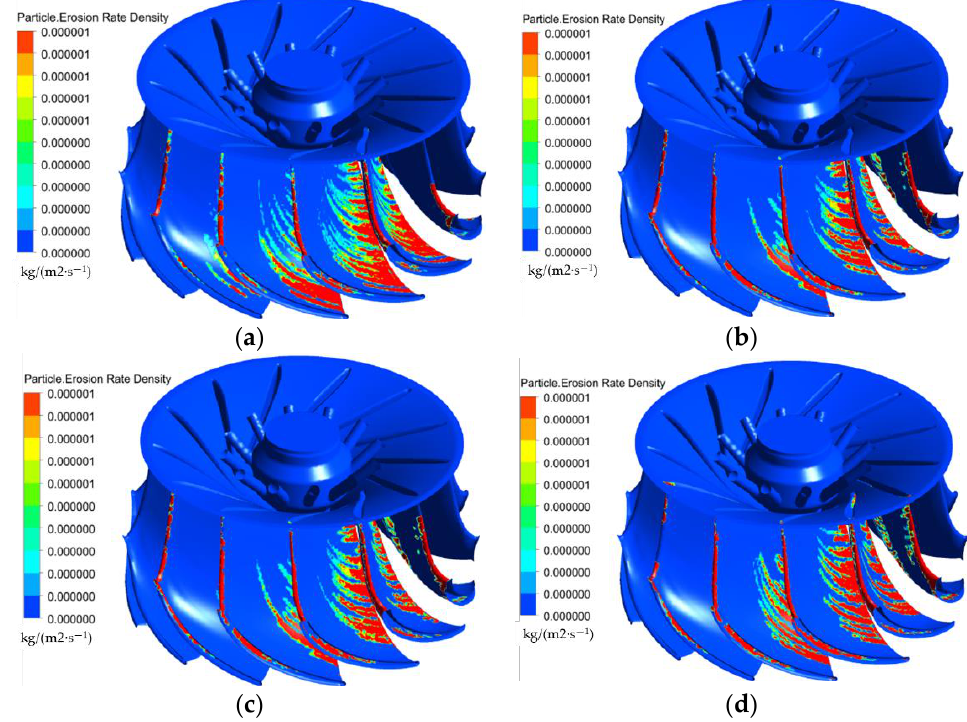
Figure 8. Runner wear under different guide vane opening. ( a ) 10°, ( b ) 20°, ( c ) 25°, ( d ) 30°.